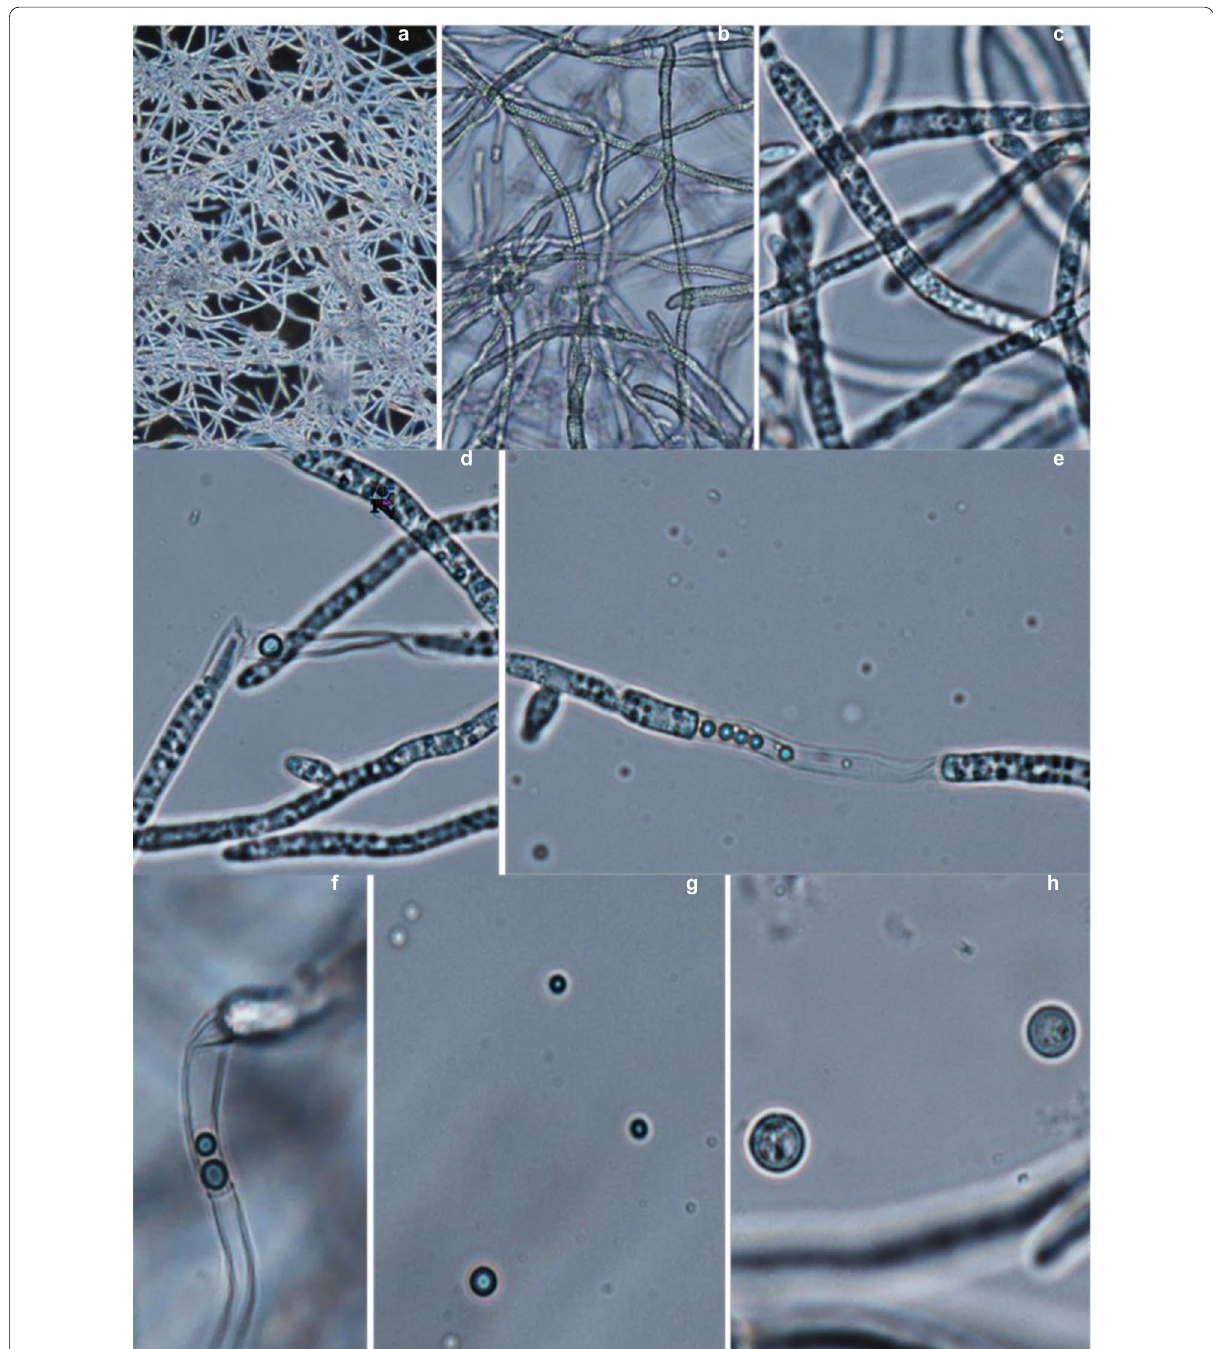
Fig. 3 Phase-contrast micrographs of Gibberella zeae VKM F-2600 mycelium of second generation stage (18 h) grown in medium no. 3 (see Table 1) (a – c) and protoplasts released from 18 h fungal cells treated with T. harzianum lytic enzymes for 5 h ( d – h ): 100x ( a ), 400 ( b ) x, 1000x ( c‑h ) (optical